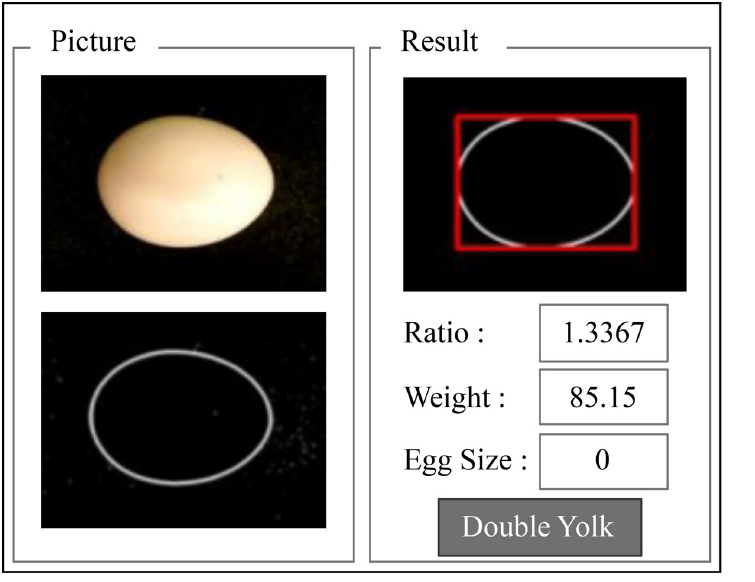
Fig 16. Interface of double yolk eggs